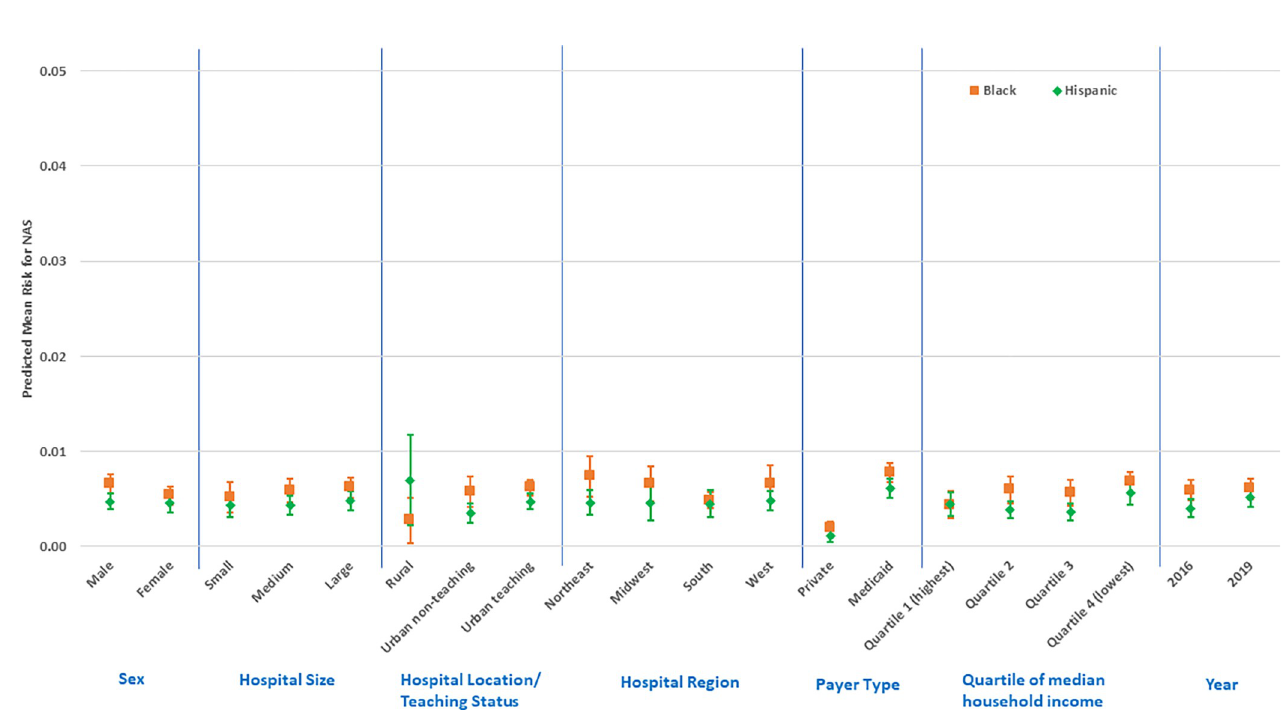
Fig 3. Predictive margins for factors related to Black/Hispanic NAS differences (risk differences and 95% confidence intervals).